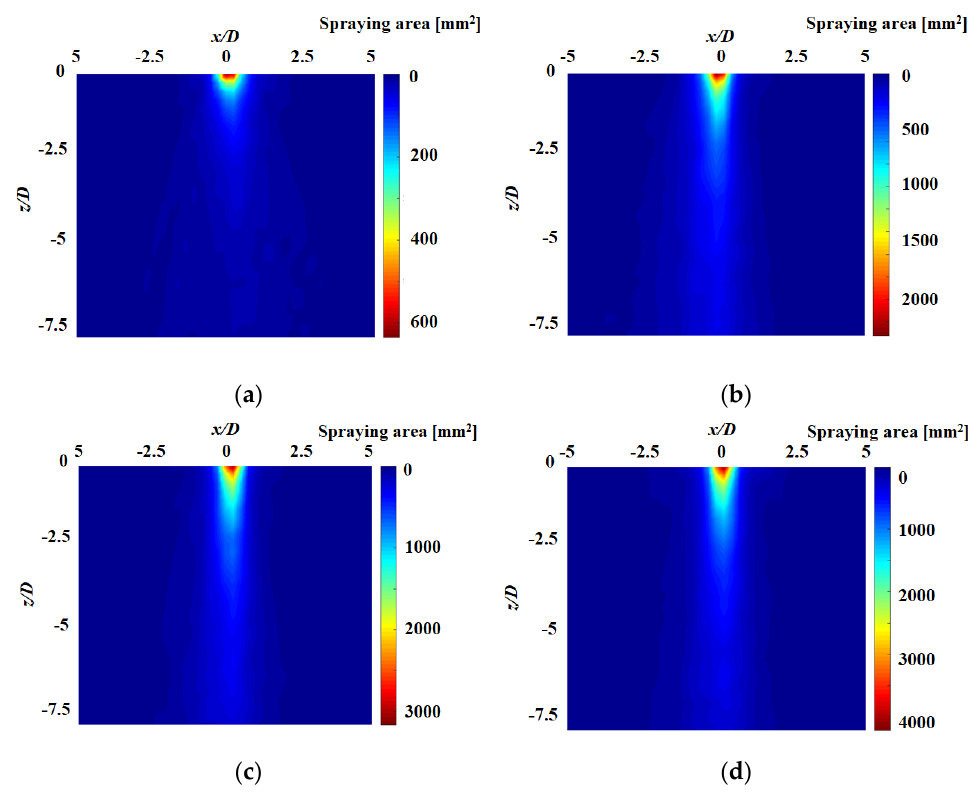
Figure 8. Contour of spraying area at the measured location of 1 in Figure 3 for the developed nozzle